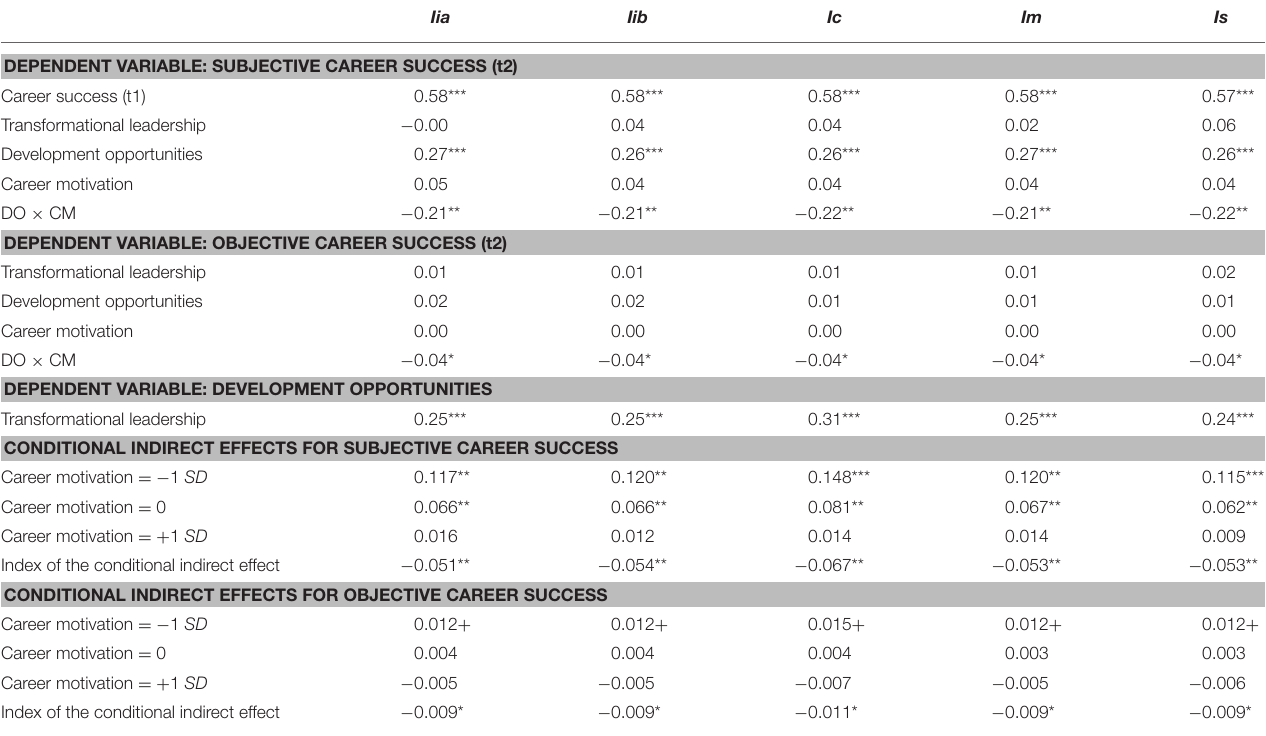
TABLE 6 | Conditional indirect effects of the sub-dimensions of transformational leadership on career success ( N = 320). Iia